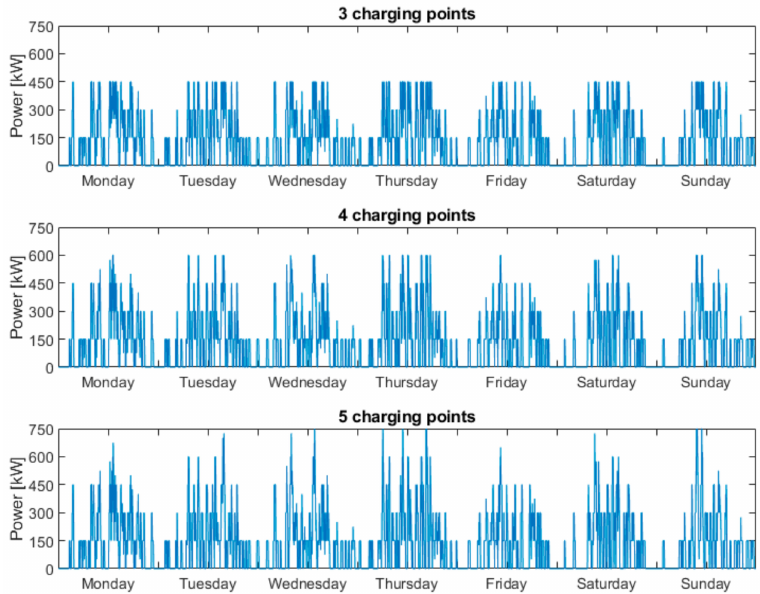
Figure 9. Stochastic distribution of 450 charging events per week for three to five